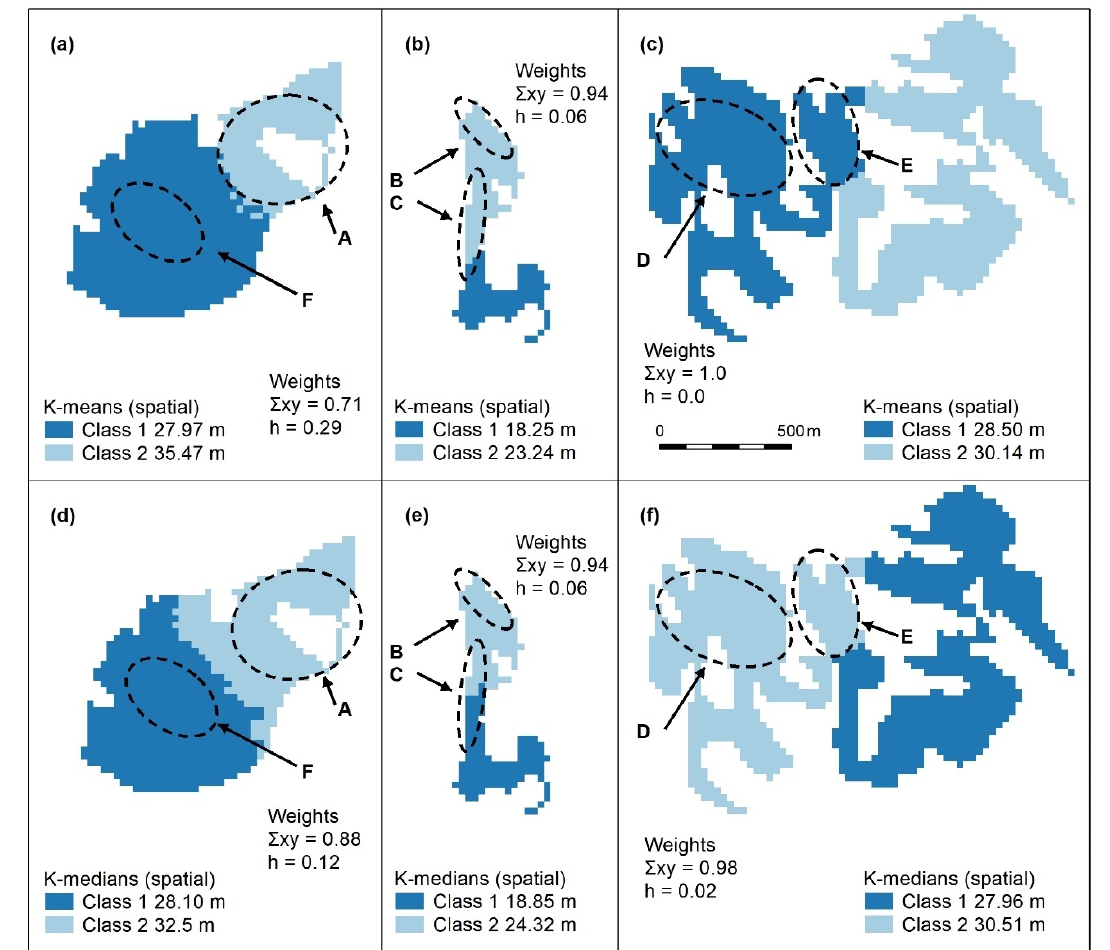
Figure A3. Spatially constrained K ‐ means ( a – c ) and K ‐ medians ( d – f ) with 2 classes. These algorithms use spatial weights ( x , y ), which, in all cases, outweigh those of the object ( h = height). Letters A–F indicate areas of higher canopy, only one of the designated features (E) is adequately captured using these algorithms ( f ). Panel scores: K ‐ means = 6 and K ‐ medians = 8.